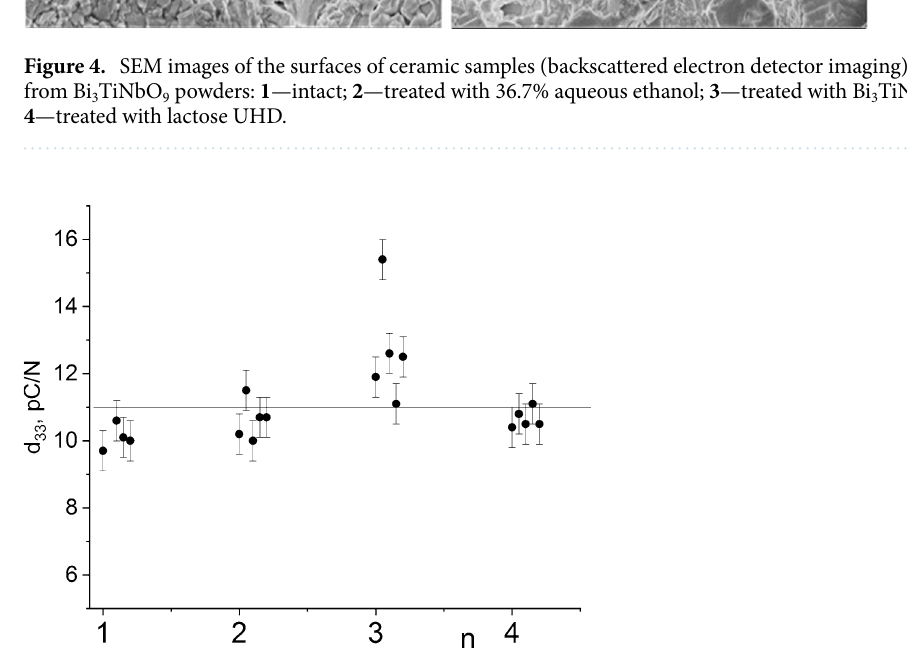
Figure 5. Piezoelectric coefficient d 33 values for Sect. 1 of hot-pressed Bi 3 TiNbO 9 samples of different series. A horizontal line corresponds to the d 33 value averaged over all measurements, equal to 11.1 pC/N. Sample modifications: (1) an intact Bi 3 TiNbO 9 powder (2) Bi 3 TiNbO 9 powder treated with 36.7% ethyl alcohol; (3) Bi 3 TiNbO 9 powder treated with Bi 3 TiNbO 9 UHDs; (4) Bi 3 TiNbO 9 powder treated with lactose